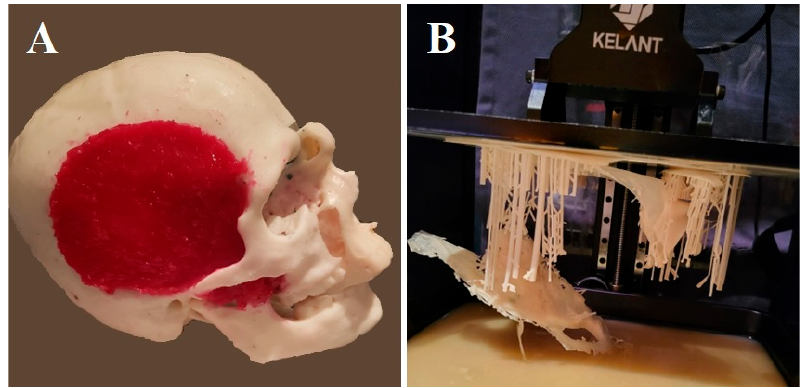
Figure 2. The 3D model ( A ) and supporting material used for printing ( B ).